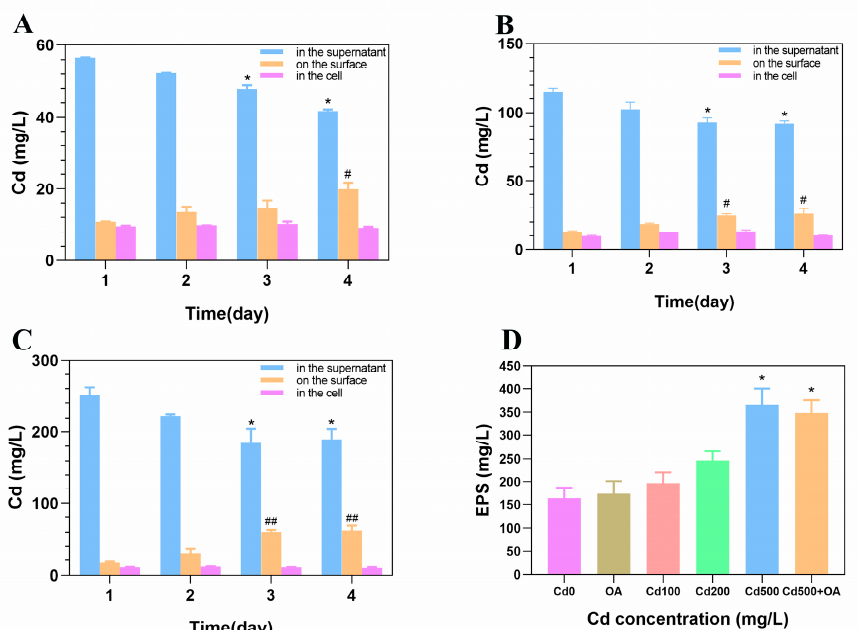
Figure 4. Cd bioaccumulation and production of EPS in B. cepacia after being exposed to ( A ) 100 mg/L, ( B ) 200 mg/L, and ( C ) 500 mg/L of CdCl 2 . * p < 0.05, # p < 0.05, and ## p < 0.01 versus corresponding group on day 1. ( D ) EPS production of B. cepacia after being exposed to 0, 100, 200, and 500 mg/L of CdCl 2 and 2 mmol/L of OA. * p < 0.05 versus the Cd 0 group .